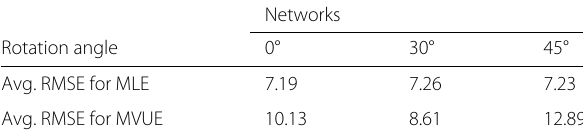
Table 2 Comparison of networks and